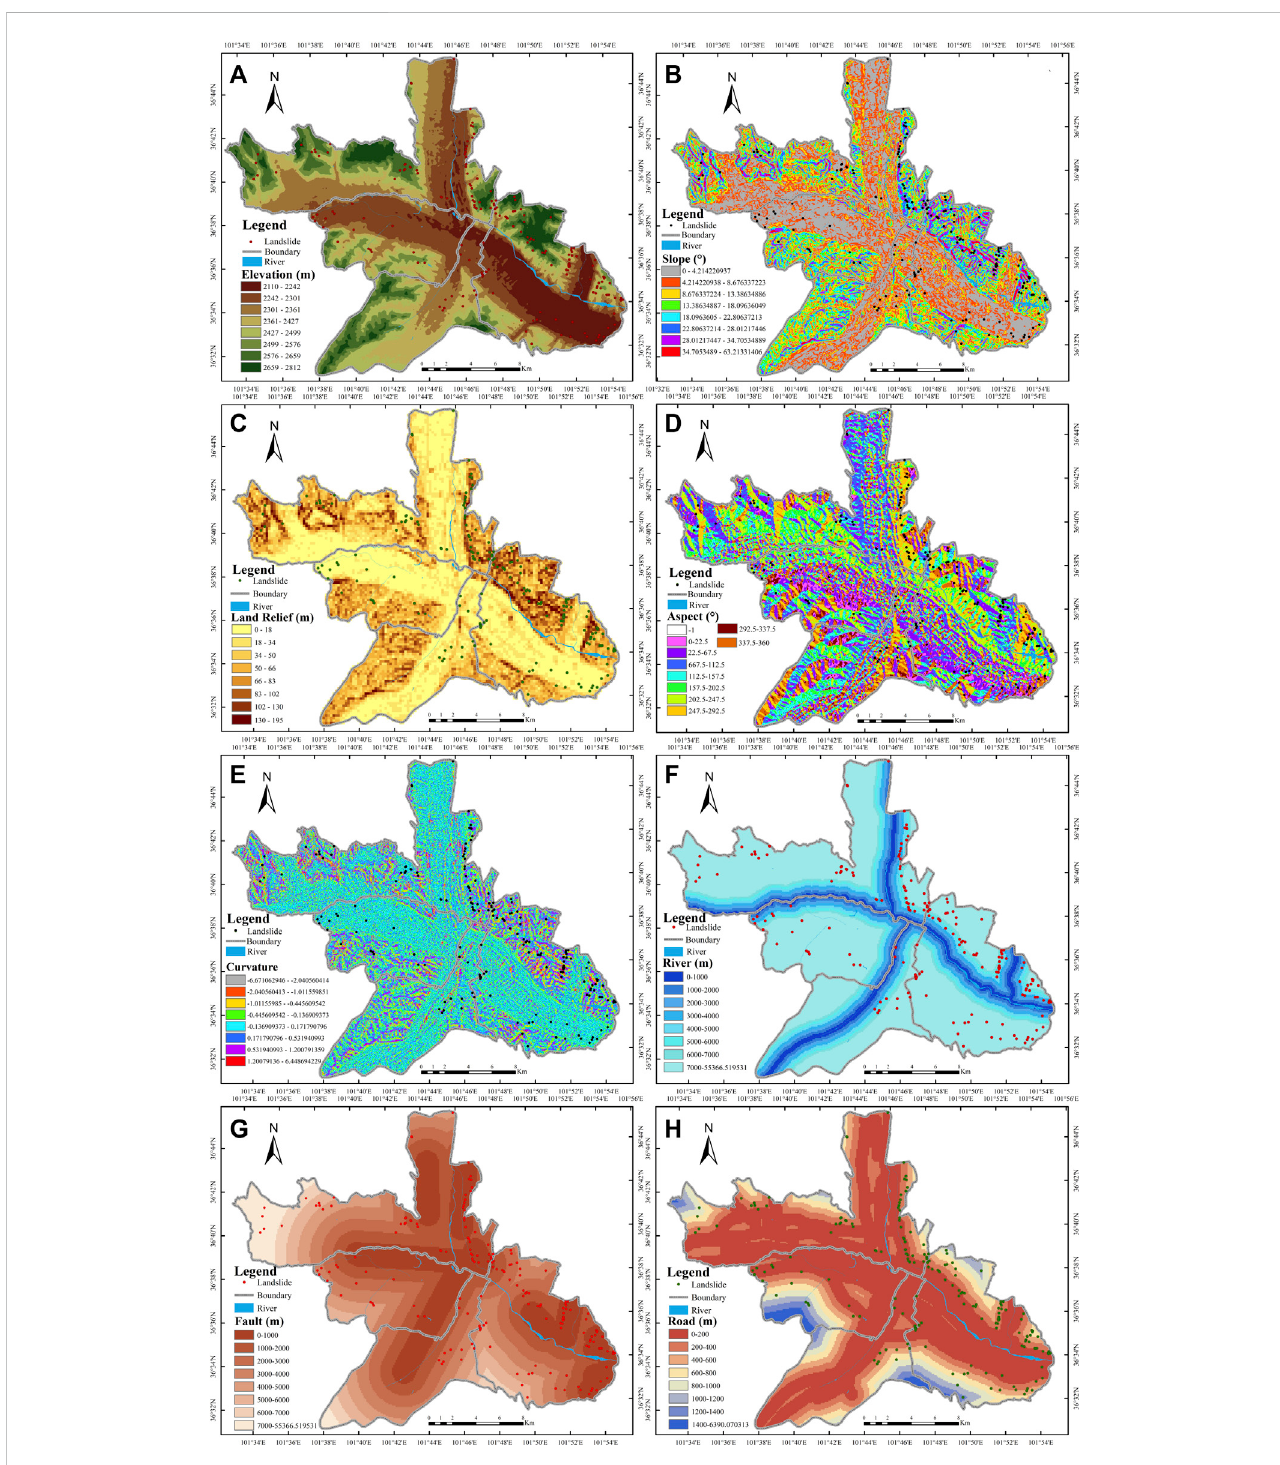
FIGURE 6 Grading maps of the evaluation factors for landslide susceptibility assessment in Xining City: (A) Elevation; (B) Slope; (C) Land relief; (D) Aspect; (E) Curvature; (F) Distance from a river; (G) Distance from a fault; and (H) Distance from a road.